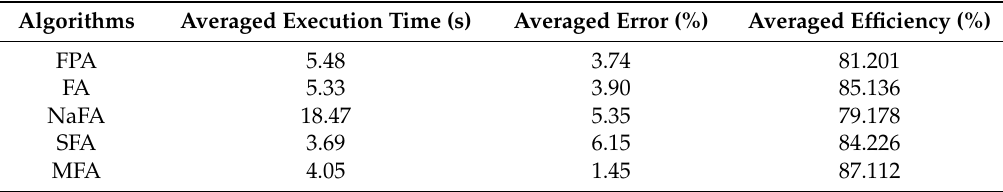
Table 15. Comparison of the evaluation results of the five